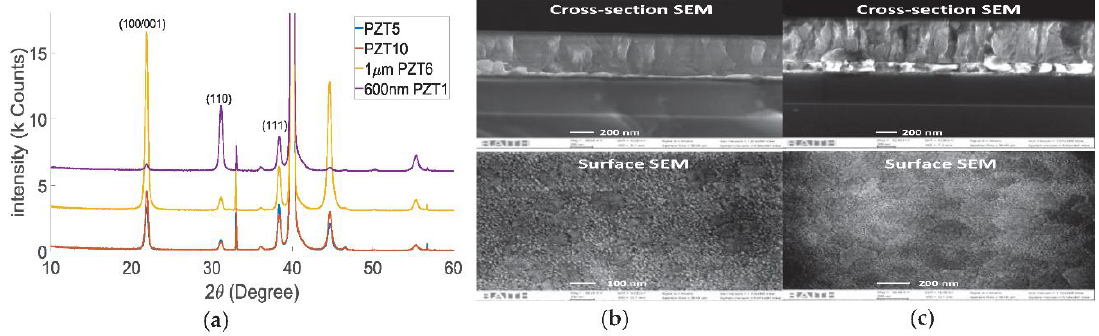
Figure 3. ( a ) XRD pattern of samples PZT5 and PZT10 (400 nm), PZT6 (1 μm), and PZT1 (600 nm); ( b ) cross-section (top) and surface (bottom) SEM images of 600 nm PZT1 and ( c ) 1 μm